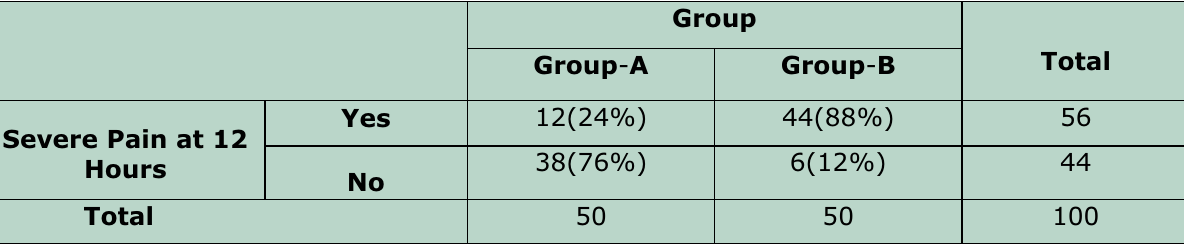
th Table-V: Severe pain at 12 hours in treatment